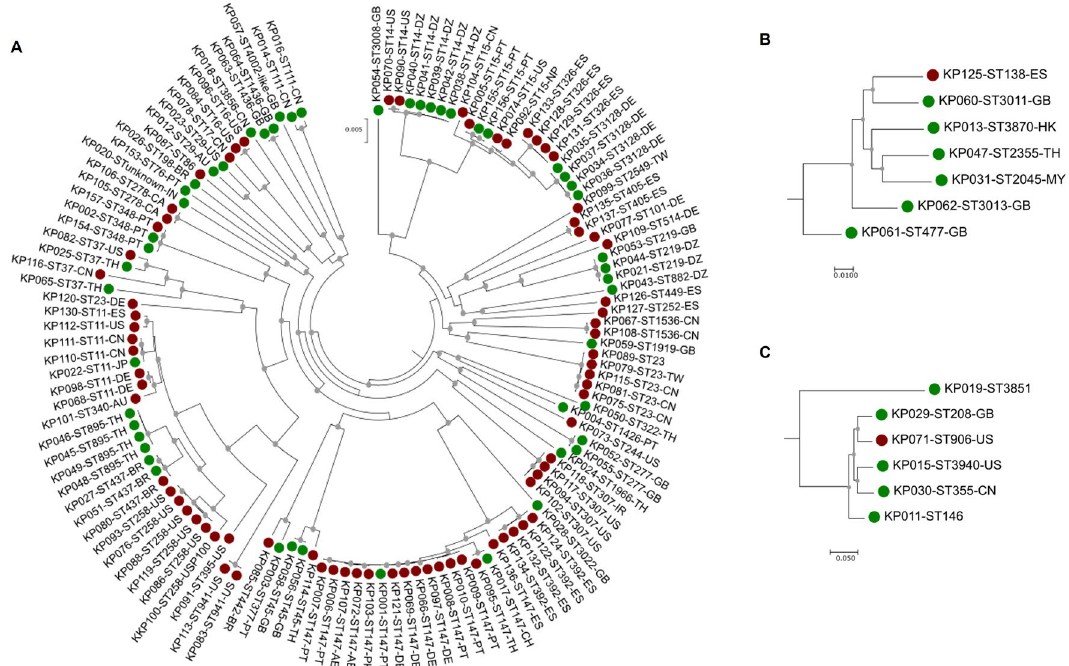
Figure 1. Phylogenetic trees based on the concatenated nucleotide sequences of the 2704 monocopy core genes defined in the ( A ) K. pneumoniae sensu stricto (n = 126), ( B ) K. quasipneumoniae and ( C ) K. variicola genomes analysed. A phylogenetic tree was constructed based on 2,542,200 bp and using the GTR evolutive model, which was determined to be the model that better fitted the data, and ( A ), ( B ) and ( C ) represent zoom sections according to the species. On the labels are indicated the name of the strain genome, the sequence type and the country of isolation. Grey circles in the nodes indicate values of bootstrap above 70%. Red and green circles indicate clinical and environmental genomes,